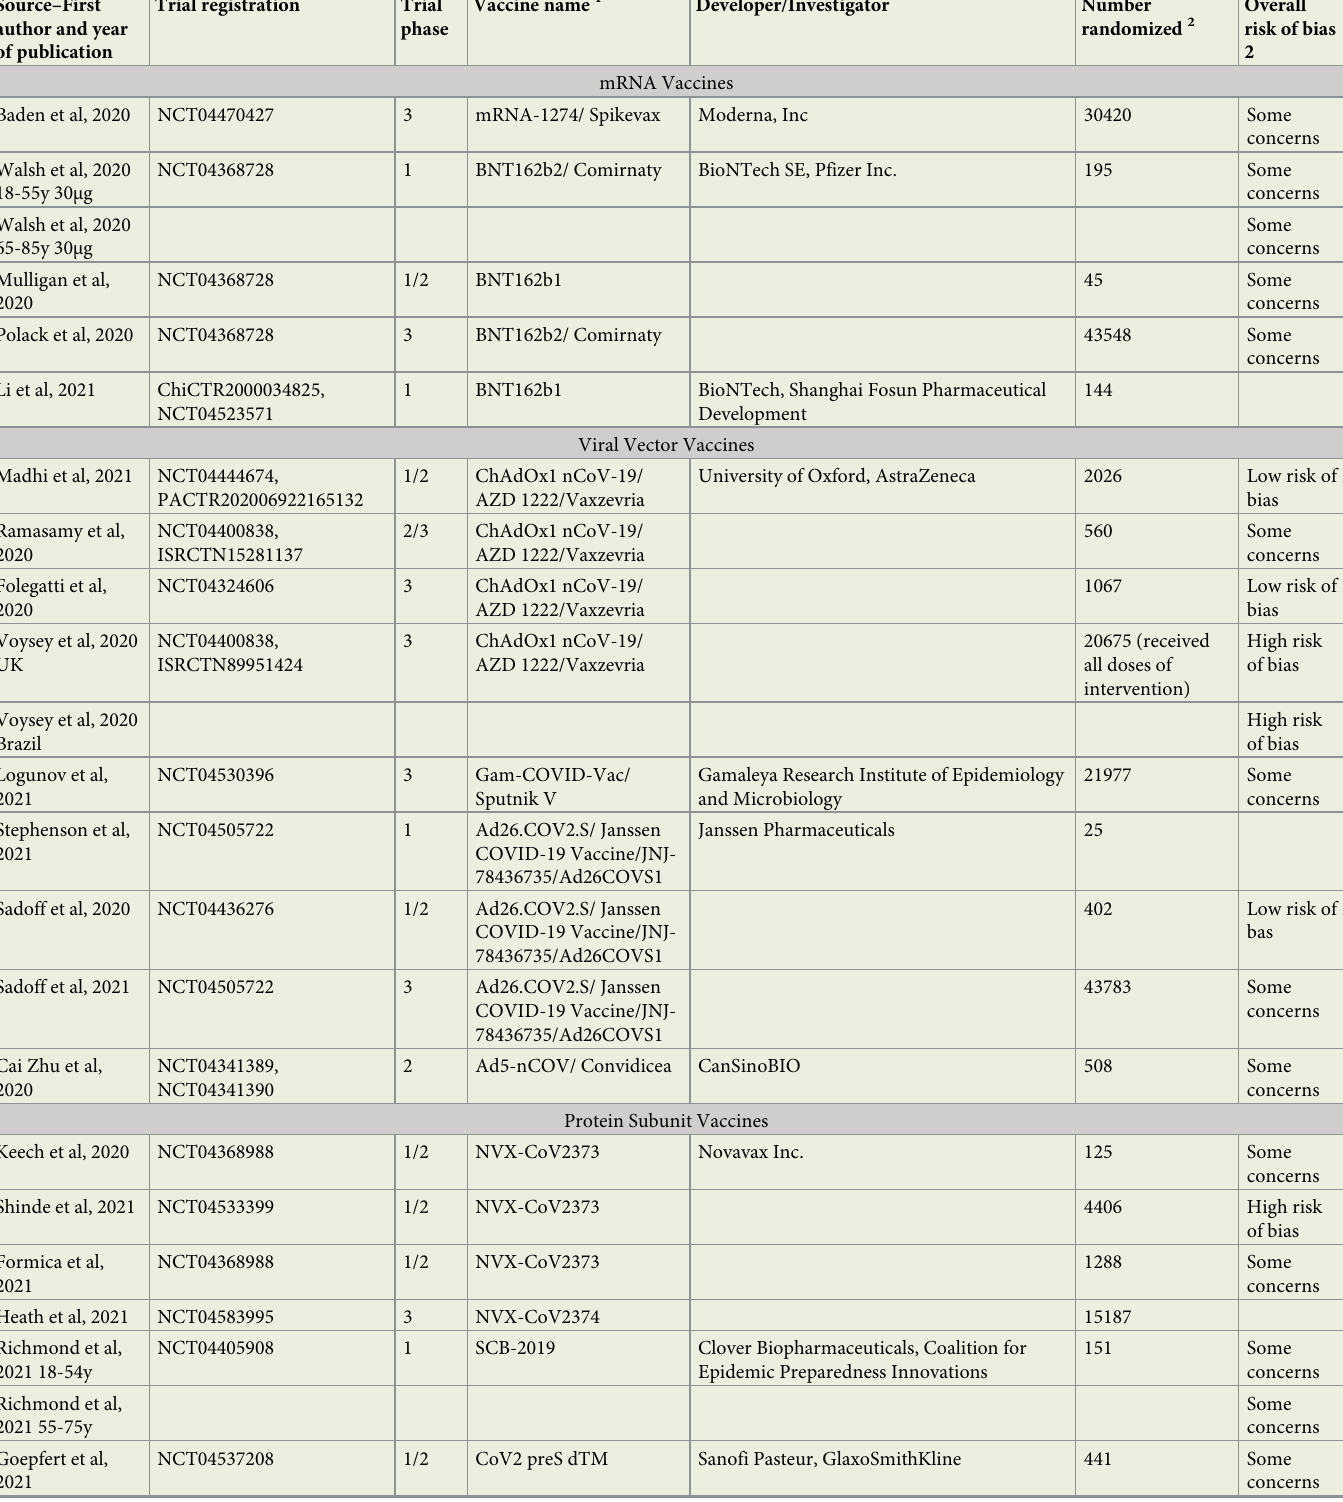
Table 5. Randomized clinical trials included in systematic review of vaccines against